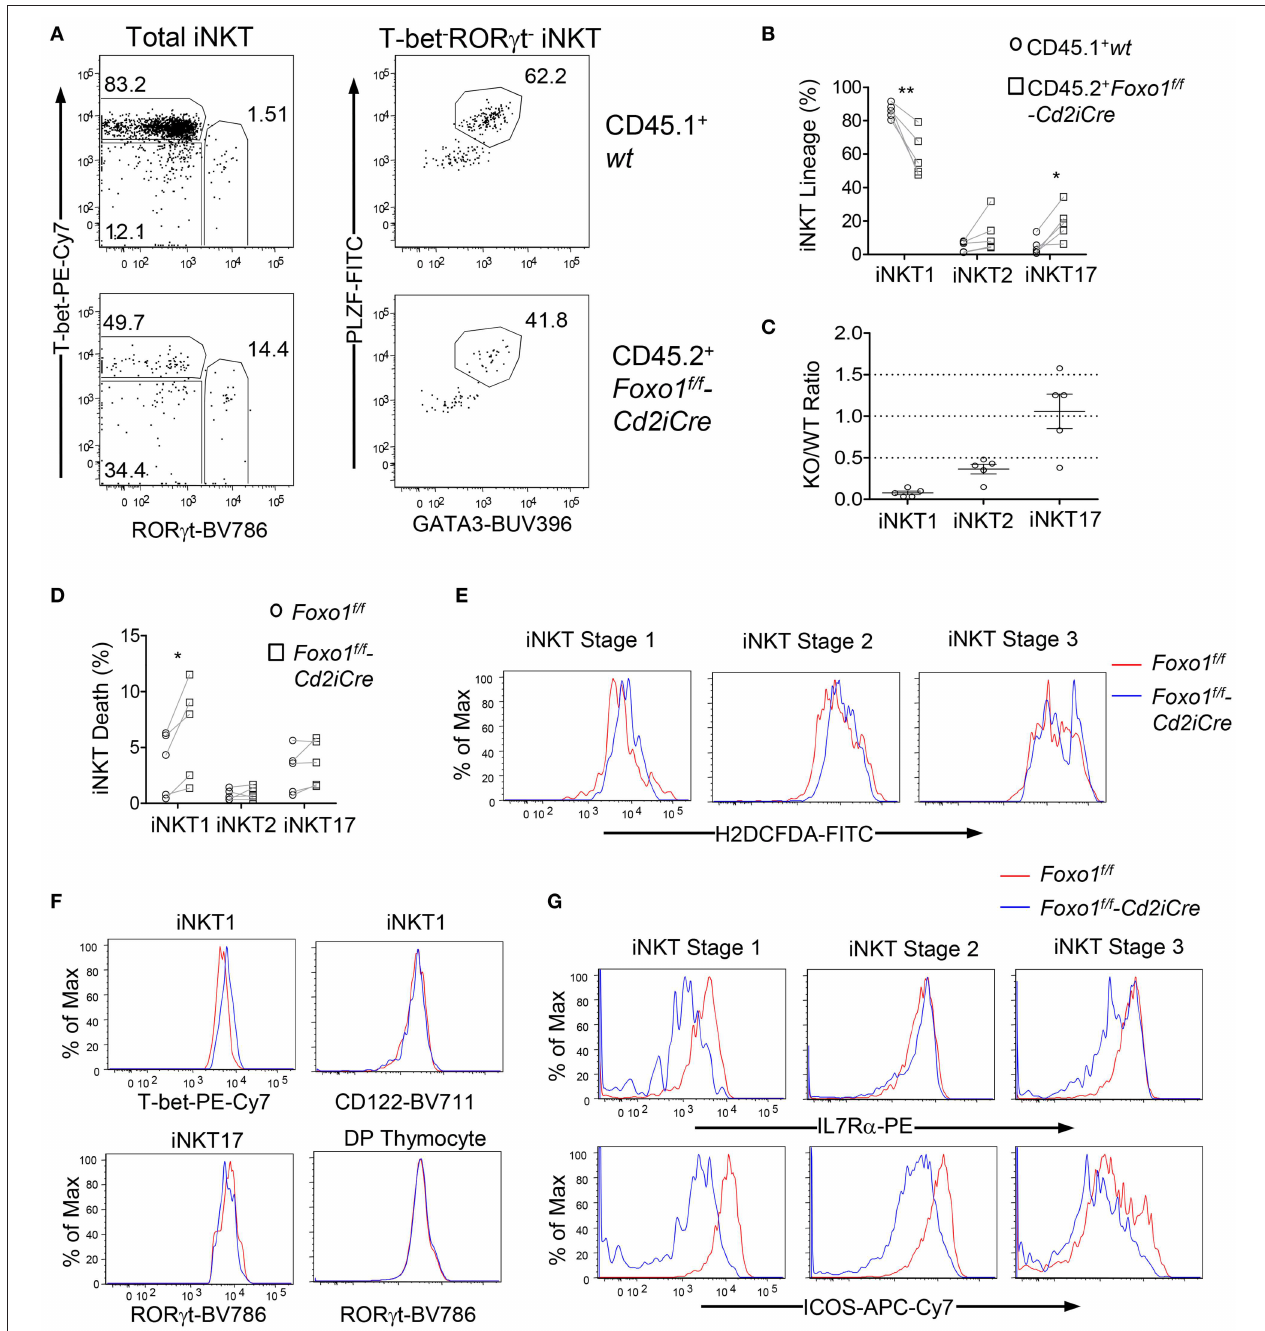
FIGURE 6 | Intrinsic control of i NKT cell effector lineage differentiation by Foxo1. (A–C) Thymocytes from mixed BM chimeric mice as described in Figure 2 were similarly analyzed. (A) Representative FACS plots showing ROR γ t and T-bet staining in gated CD45.1 + WT and CD45.2 + Foxo1KO i NKT cells (left panels) and PLZF and GATA3 staining in gated ROR γ t − T-bet − i NKT cells. (B) Scatter plots showing percentages of i NKT effector lineages. (C) Scatter plots showing CD45.2 Foxo1KO/CD45.1WT ratios of individual i NKT effector lineages. Data shown are representative or pooled from five experiments. Connecting lines indicate CD45.1 WT and CD45.2 Foxo1KO i NKT cells in individual mice. One chimeric mouse was examined in each experiment.* p < 0.05; ** p < 0.01 determined by two-tail pair-wised Student t -test. (D–G) Two to three weeks old Foxo1 f / f -Cd2iCre and Foxo1 f / f mice were analyzed for thymic i NKT cells by flow cytometry. (D) Death rates of i NKT effector lineages detected by Live/Dead TM Fixable Violet Dead Cell Stain. N = 5. * p < 0.05 determined by two-tail pair-wised Student t -test. (E) Overlaid histograms show ROS levels in stages 1–3 i NKT cells. (F) Overlaid histograms show T-bet and CD122 levels in i NKT1 cells and ROR γ t levels in i NKT17 cells and in DP thymocytes. (G) Overlaid histograms show IL7R α and ICOS levels in stages 1–3 i NKT cells. Data in (E–G) are representative of three experiments.